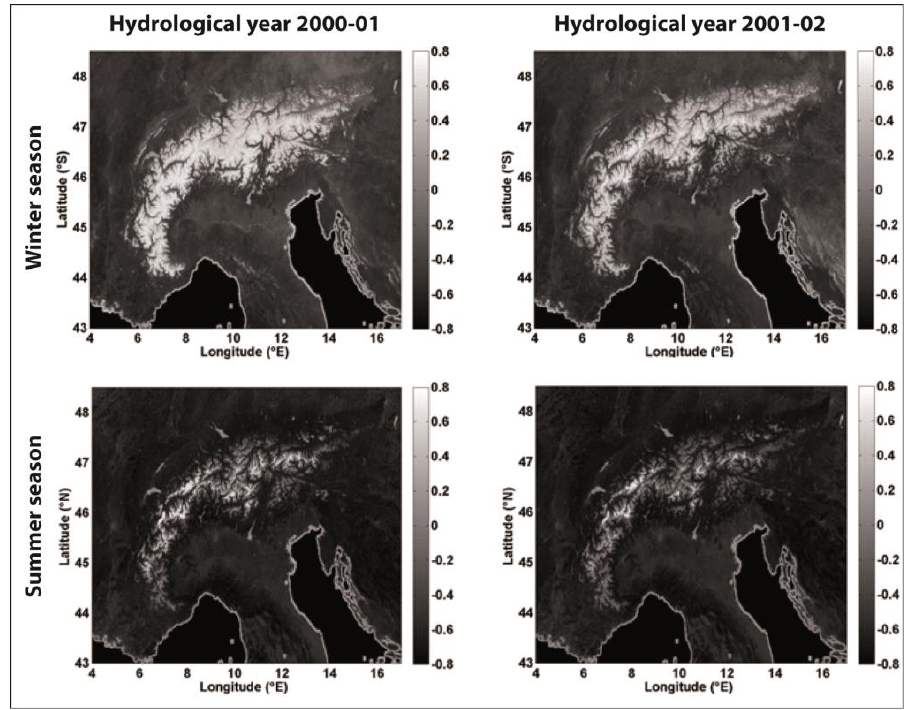
Figure 8. Example of regional seasonal snow maps over the European Alps for two contrasted hydrological years produced by averaging all normalized difference snow index (NDSI) syntheses included between 1 October and 30 April for the winter season and between 1 May and 30 September for the summer season.